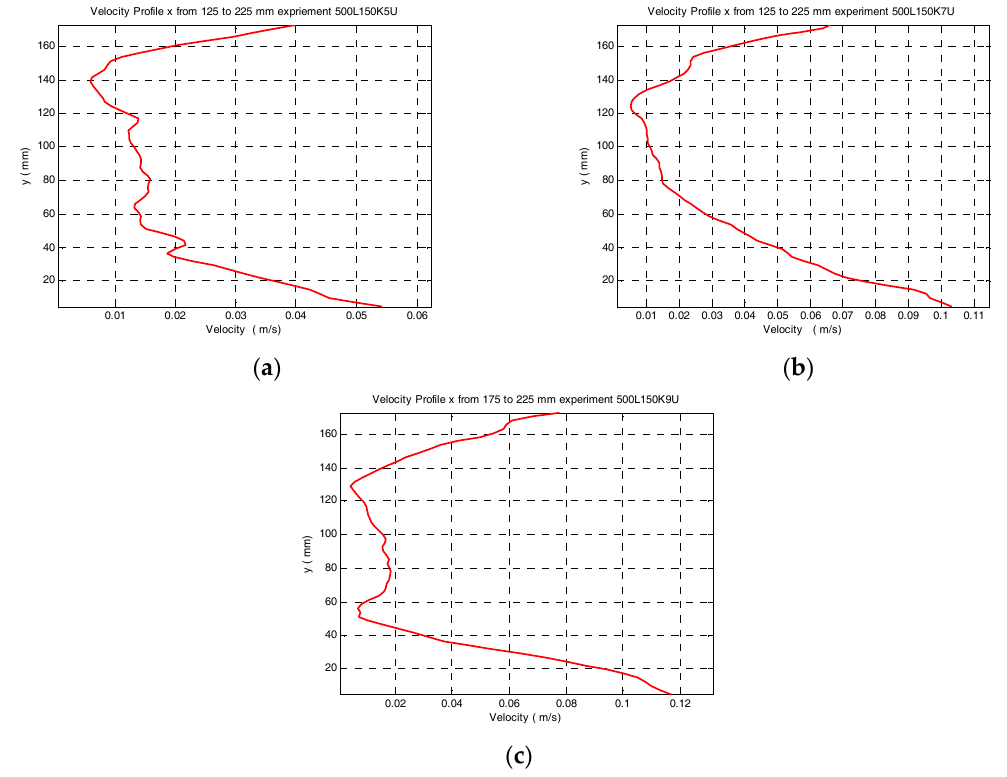
Figure 5. Velocity profiles downstream (position 2) in front of the second mussel shock, when the line connecting the shocks form an angle with the central axis of the channel (and thus with the main stream) for velocity at the entrance of the channel ( a ) 5 cm/s, ( b ) 7 cm/s and ( c ) 9